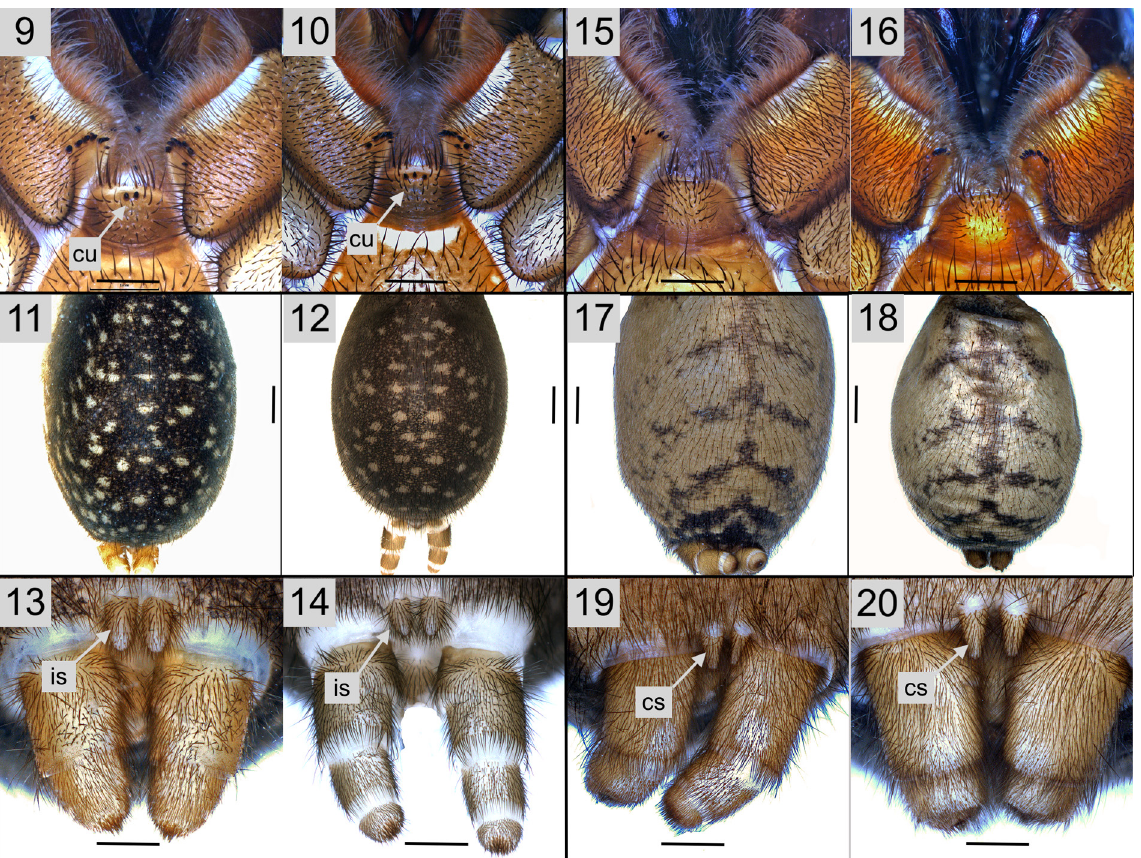
Figs 9–20. Characters distinguishing Nemesia arboricola Pocock, 1903 from N. macrocephala Ausserer, 1871. 9–14 . N. arboricola ; represented by two specimens (TC.016, NHMR, Figs 9, 11, 13,